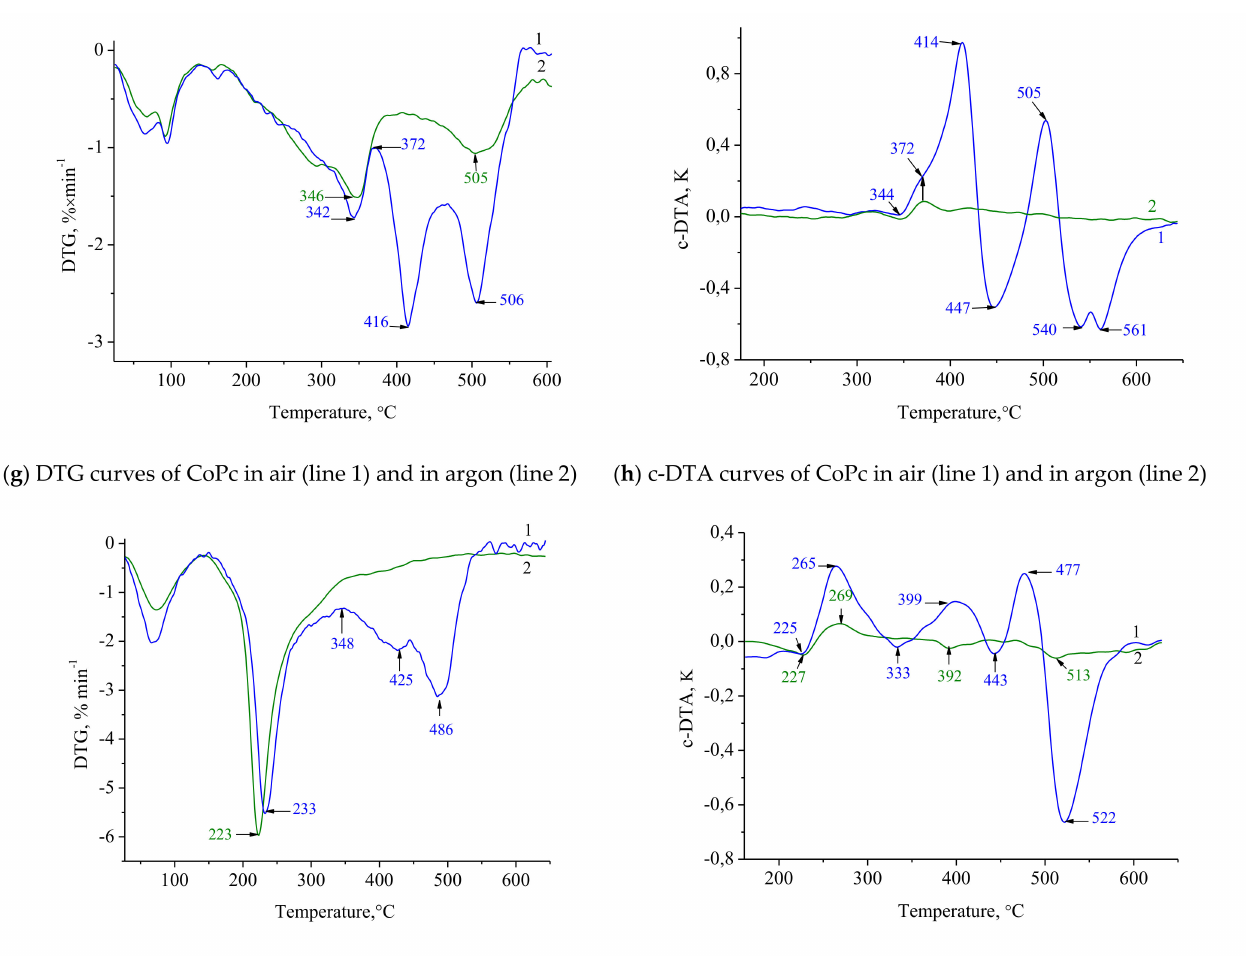
Figure 3. DTG and c-DTA curves of individual CS, CoPc, CuPc and their complexes CS-CoPc and